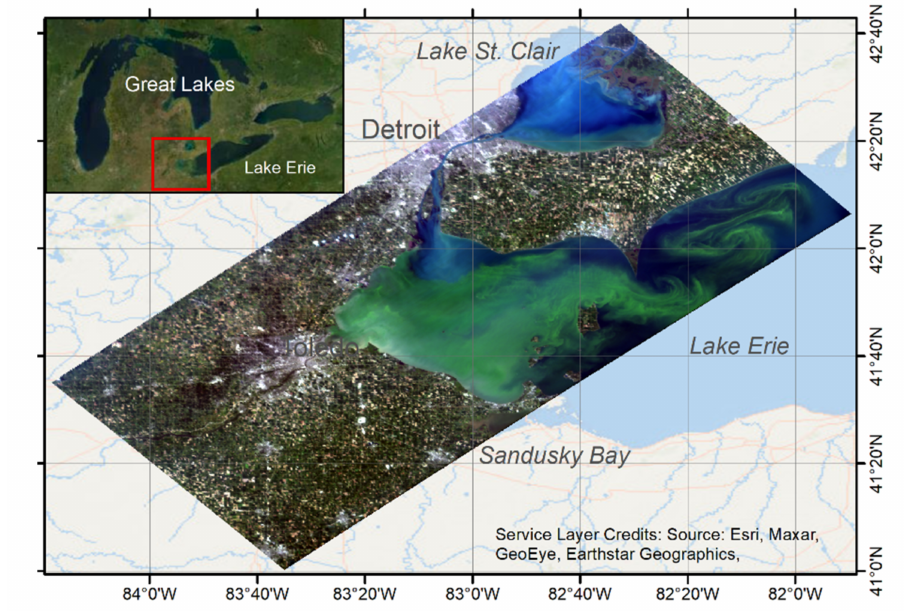
Figure 3. Location of the utilized HICO scene H201124617359 in Lake Erie as true color image. (Data source: NASA Ocean Color